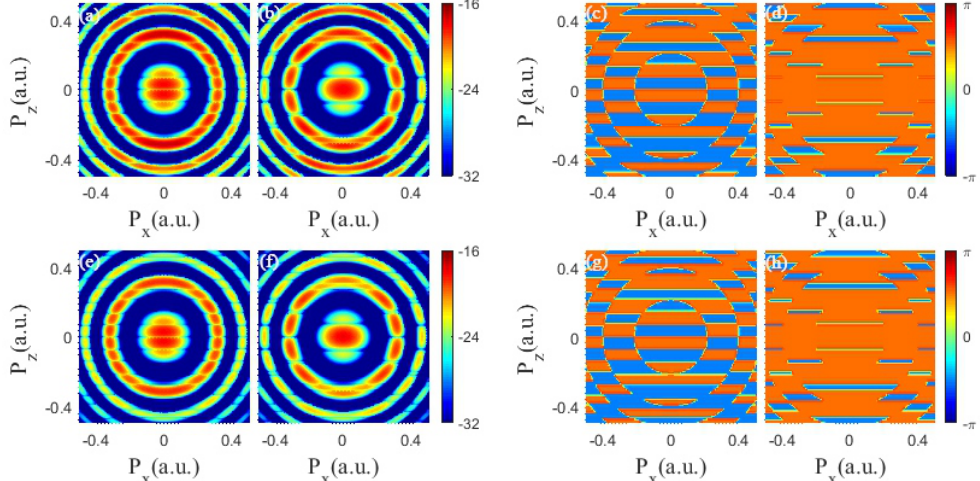
Figure 2. Top : RPC spectra (first order ( a ); second order ( b )) obtained by infinite series expansion of the generalized Bessel function, with corresponding PP spectra [first order ( c ); second order ( d )]; Bottom : RPC spectra (first order ( e ); second order ( f )) obtained using the strong − field − tunneling approximation of the generalized Bessel function, with corresponding PP spectra [first order ( g ); second order ( h )].